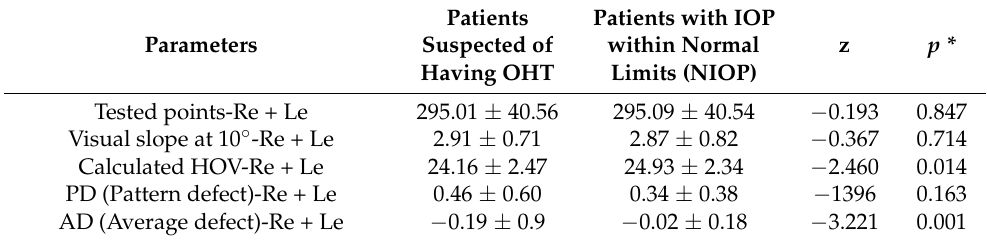
Table 5. Distribution of “visual field” parameters in OHT suspects and NIOP patients. Patients Parameters Having OHT